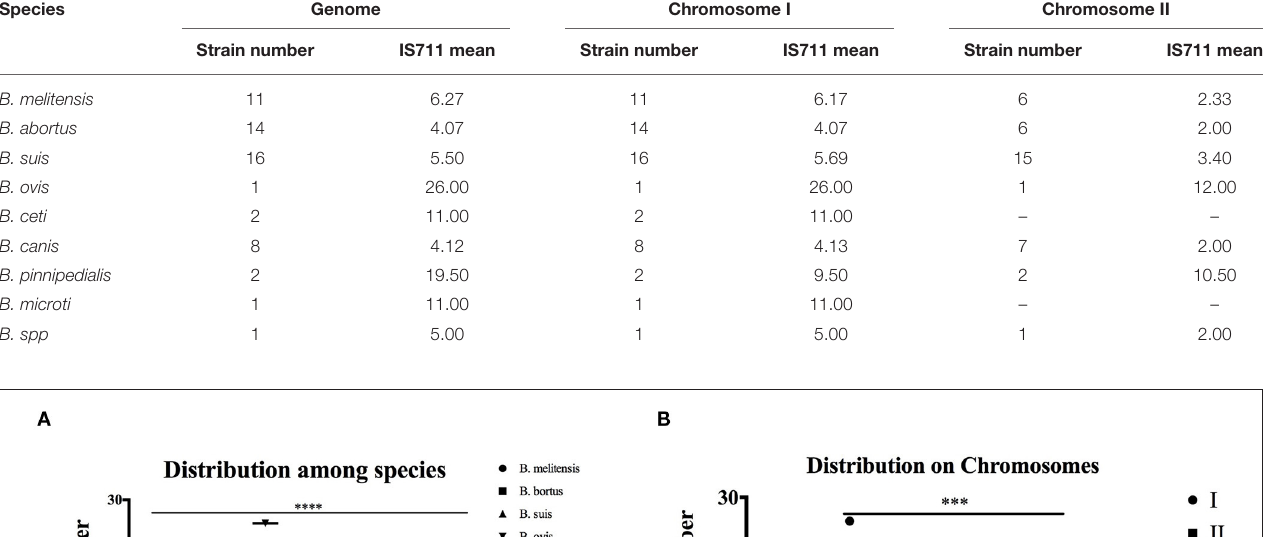
TABLE 2 | Copy distribution of IS711 among different species.